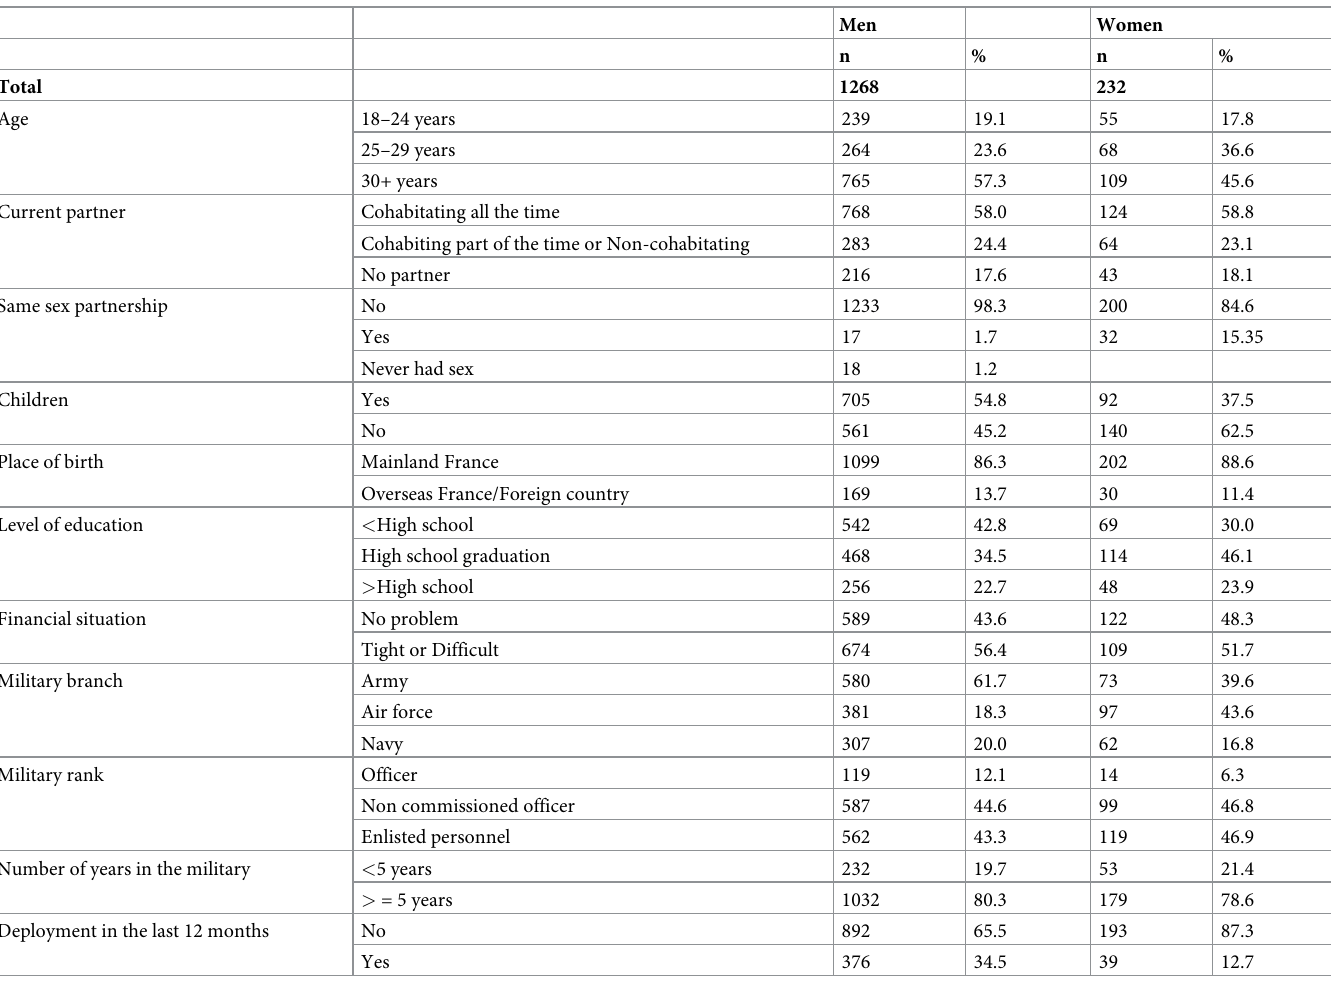
Table 1. Characteristics of French active duty servicemen and women included in the COSEMIL survey (n =